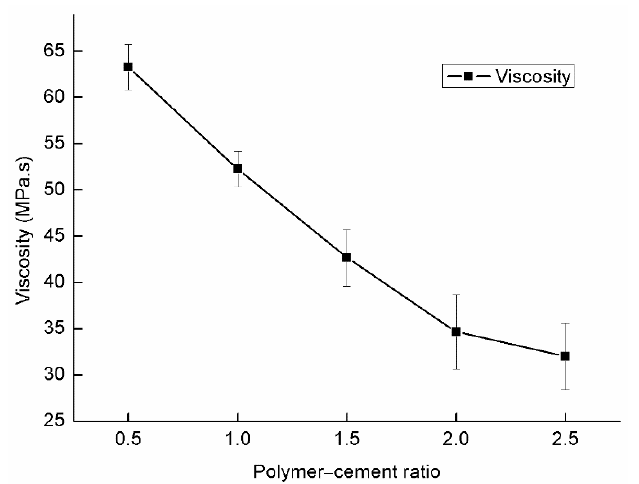
Figure 7. Relationship between polymer–cement ratio and viscosity.